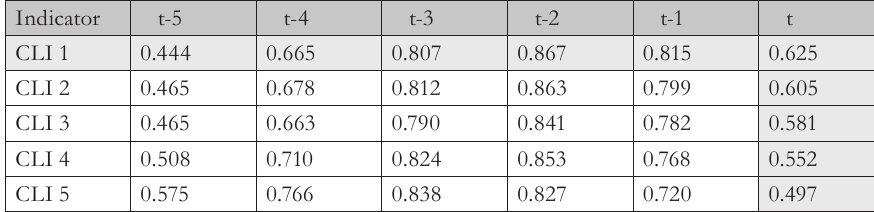
Tab. 4 – Cross-correlation results between CLI and GDP, equal weight, Q1 2000 – Q4